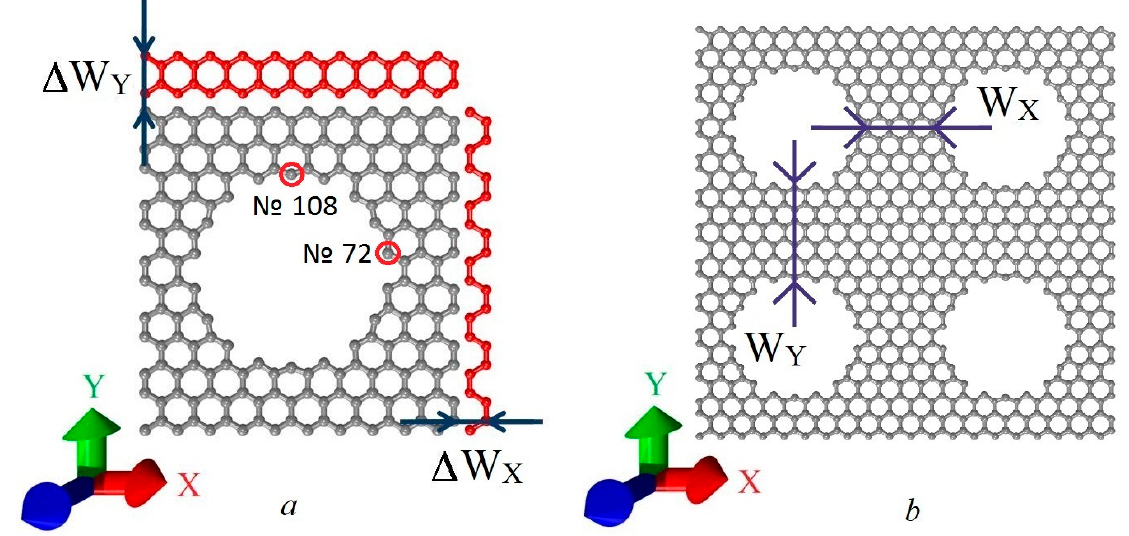
Figure 1. ( a ) HG supercell with the minimum possible steps for increasing the neck width along the zigzag ( ∆ W X ) and the armchair ( ∆ W Y ) direction; ( b ) the neck width along the zigzag (W X ) and the armchair (W Y ) directions.